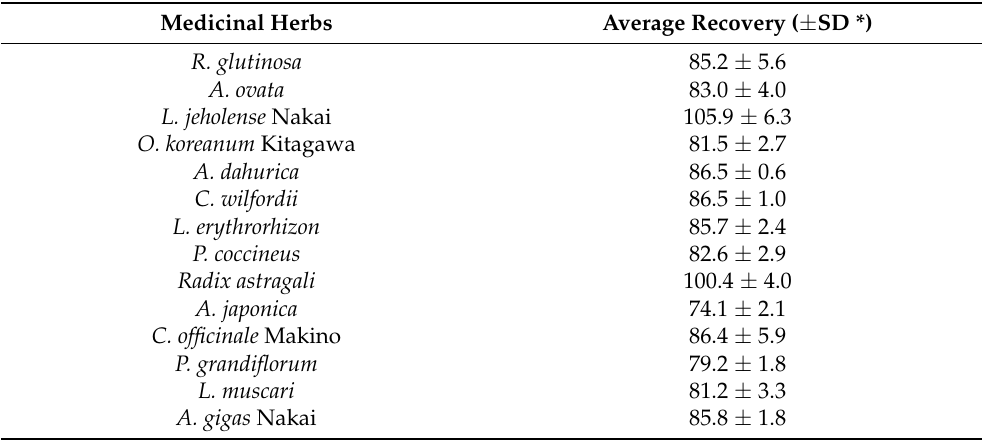
Table 2. Recovery (%) of indoxacarb in 14 medicinal herbs analyzed by GC–MS/MS. Medicinal Herbs